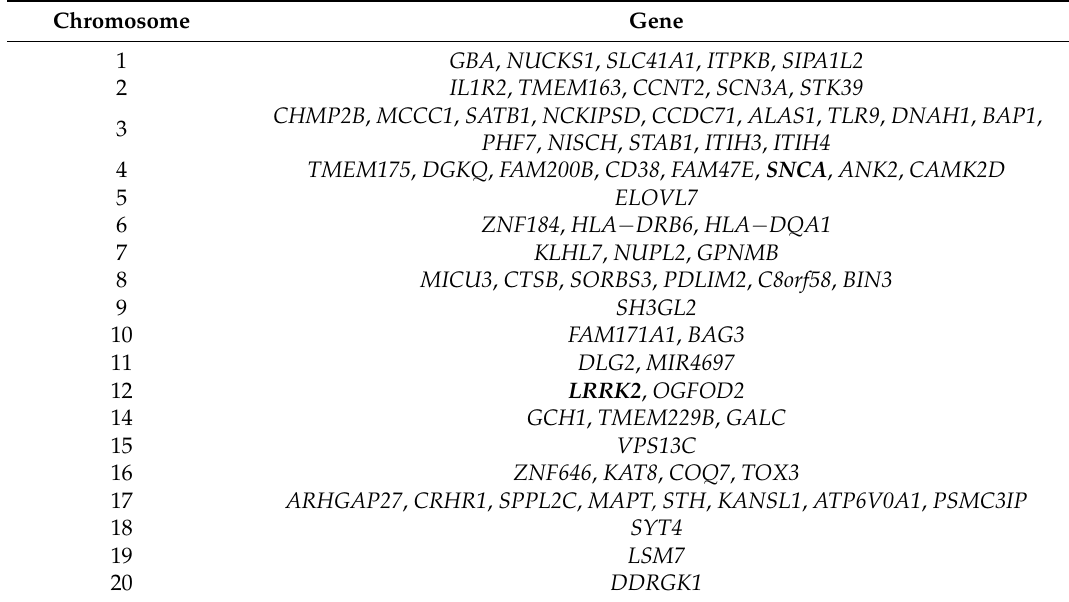
Table 1. The candidate genetic risk factors for Parkinson’s disease (PD) identified in a recent genome-wide association study (GWAS) meta-analysis. The table is adapted from [81]. Genes in bold font are also linked to the monogenic forms of familial